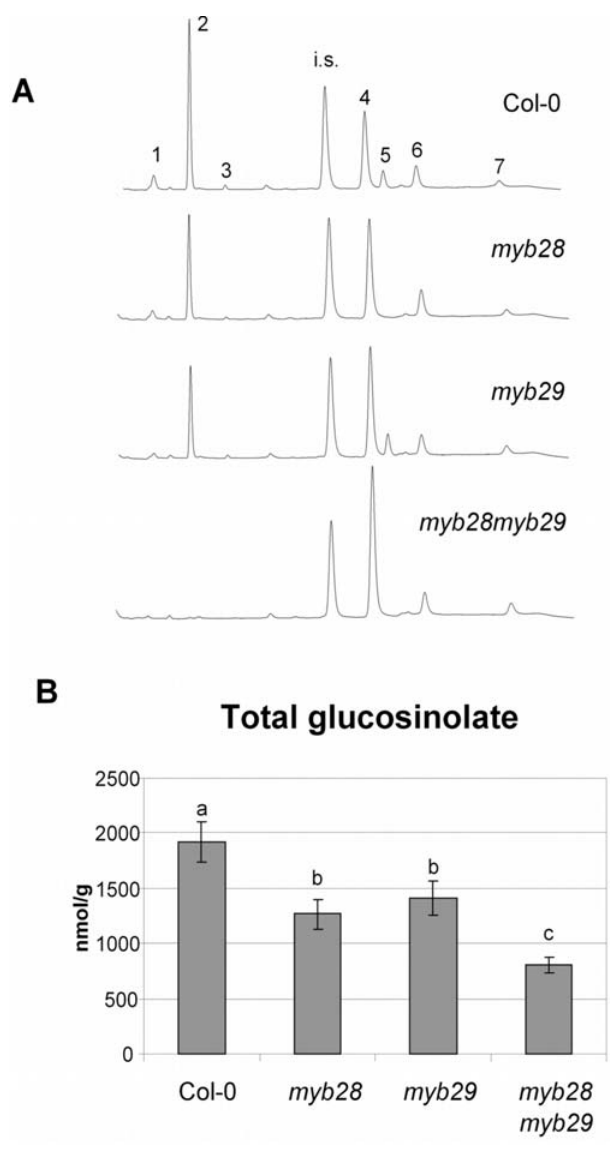
Figure 4. Glucosinolate contents of Arabidopsis lines. (A) HPLC profiles of glucosinolate extracts recorded at 229 nm. Numbers indicate glucosinolates: 1: glucoiberin (C3); 2: glucoraphanin (C4); 3: glucoalyssin (C5); 6: glucobrassicin (indole); 5: glucohirsutin (C8); 6: 4-methoxyglu- cobrassicin (indole); 7: neoglucobrassicin (indole); i.s.: internal standard (glucotropaeolin). (B) Total glucosinolate concentration in leaves of wild type (Col-0) and mutant plants ( myb28 , myb29 , myb28myb29 ). Different letters on top of the bars indicate significance difference at p , 0.05 (Tukey post hoc test).